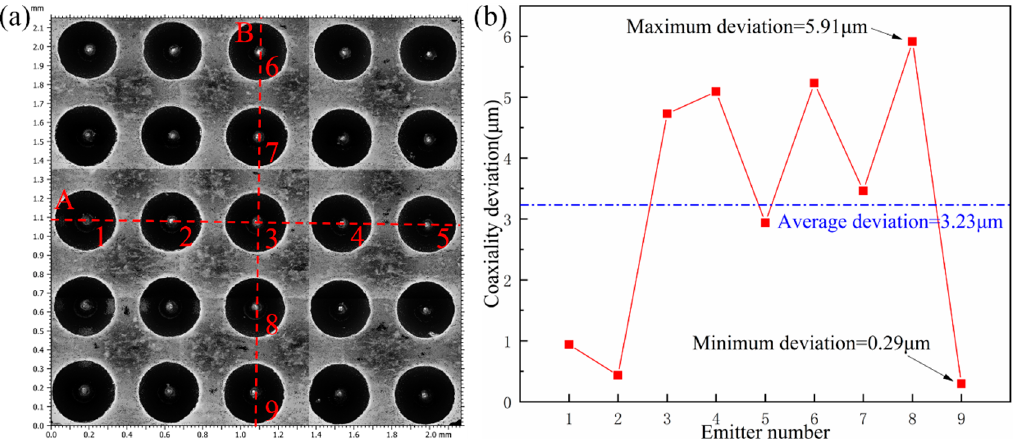
Figure 10. ( a ) Image of the 5 × 5 aperture array and ( b ) the measurement results of the deviation between the emitter tip and extractor’s aperture.